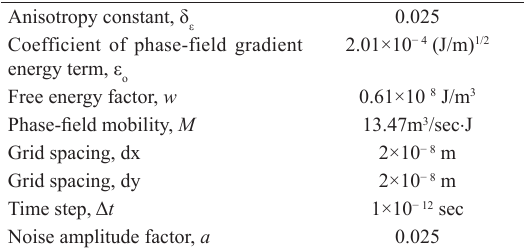
Table 1. Model parameters (Ni).